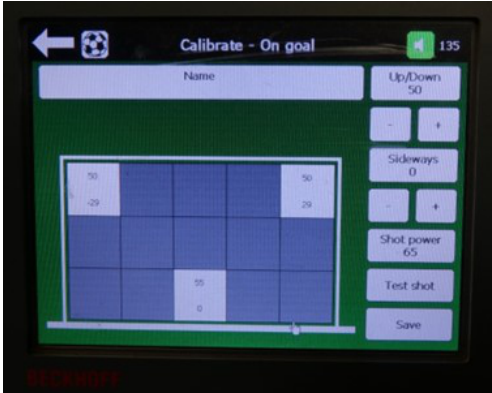
Figure 9. Ball Training Machine—On Screen